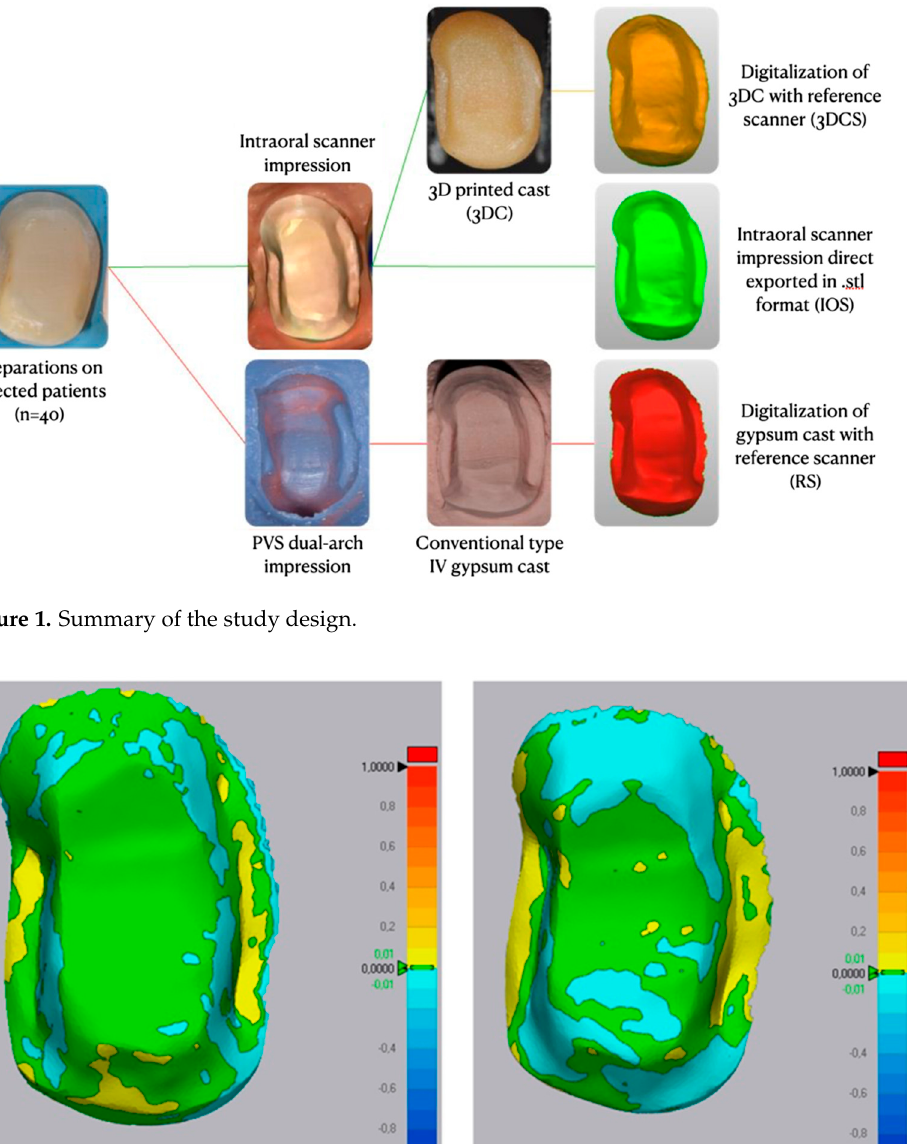
Figure 1. Summary of the study design.